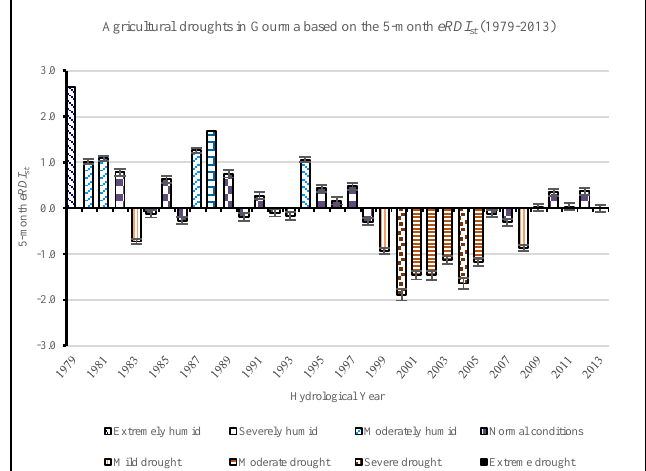
Figure 2: The Agricultural drought events that have historically manifested in Gourma (1979-2013) based on the 5-month eRDI st values i.e. bars with negative values < -0.49. - The events show varying characteristics in terms of severity, frequency and